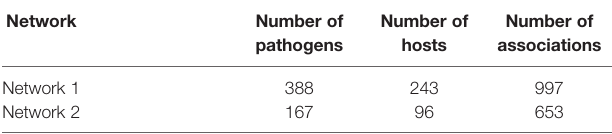
TABLE 1 | The constructed network 1 and network